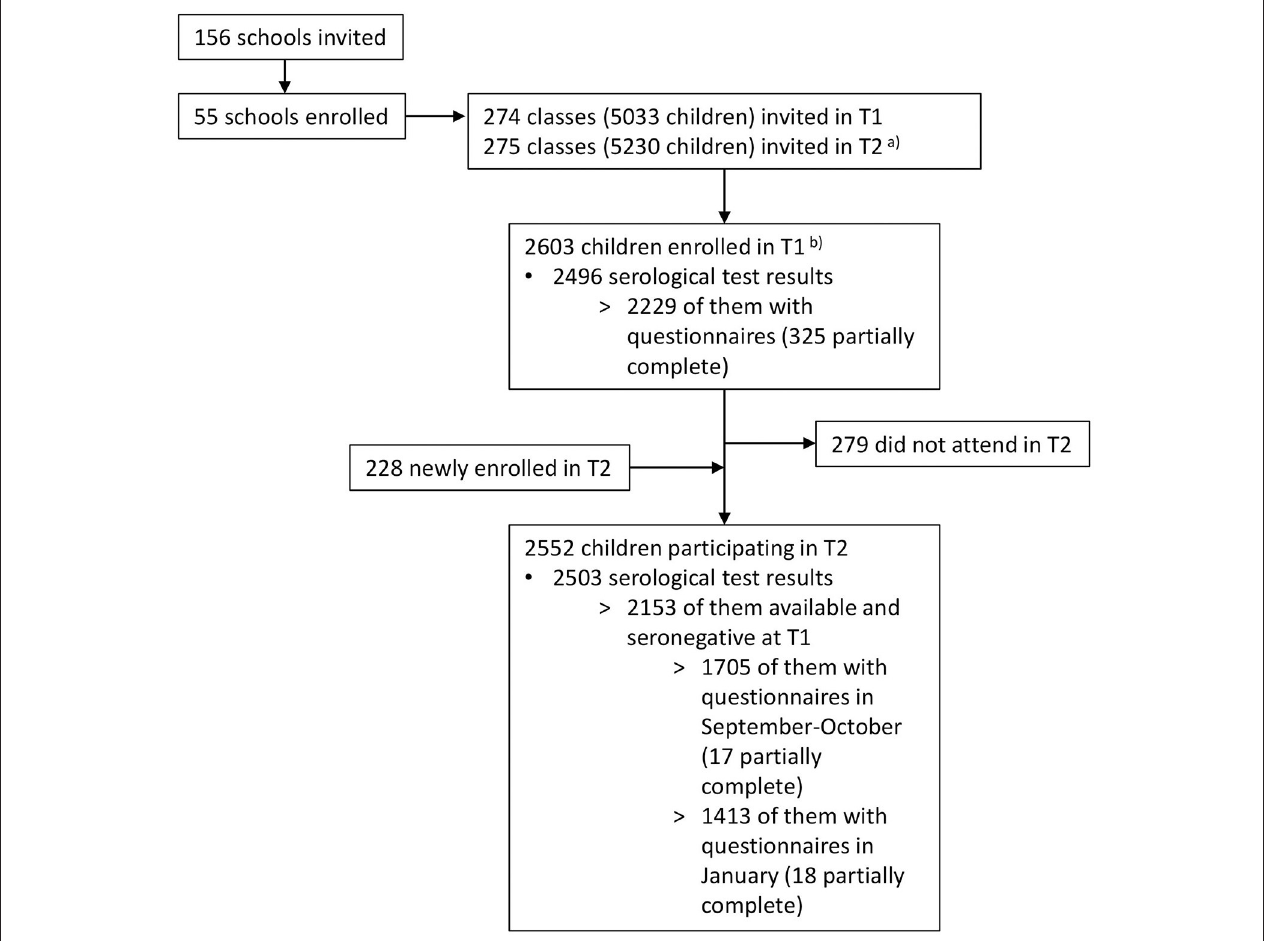
FIGURE 2 | Flowchart of study participants. T1, June 16 to July 9, 2020; T2, October 26 to November 19, 2020. a Some classes were split or rearranged into multiple classes after summer break. b Eighteen of these children were enrolled from late August to early September 2020 (12 serology results, 18